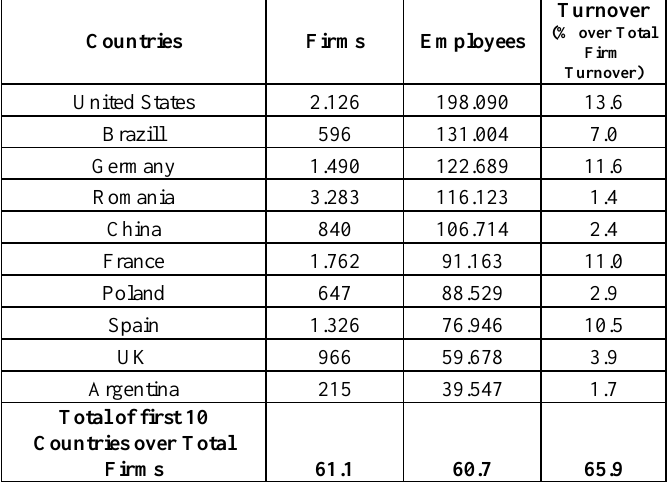
Table 2: Location of Italian Companies Abroad in 2011. Top Ten Countries Countries Firms